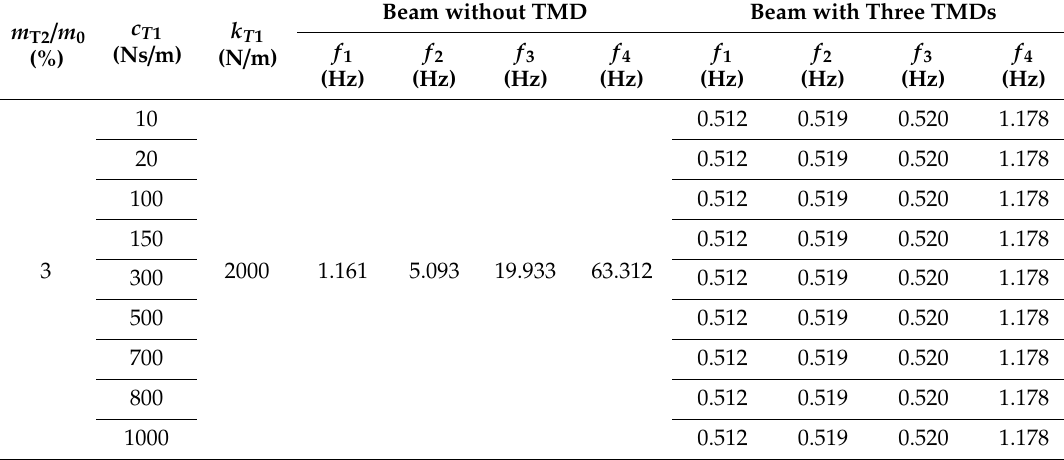
Table 5. Variation of the first natural frequencies as a function of c